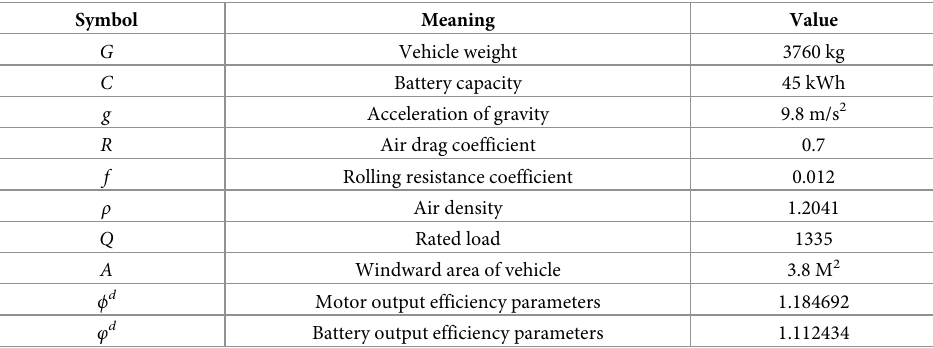
Table 4. EV related energy consumption calculation parameters.